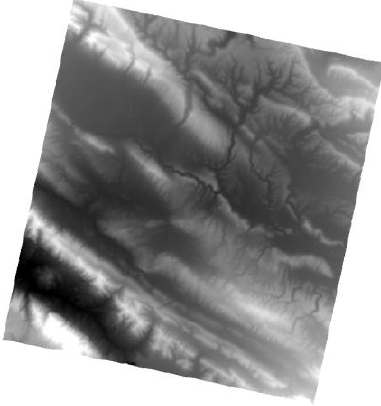
Figure 3. The relative generated DEM using raw RPCs